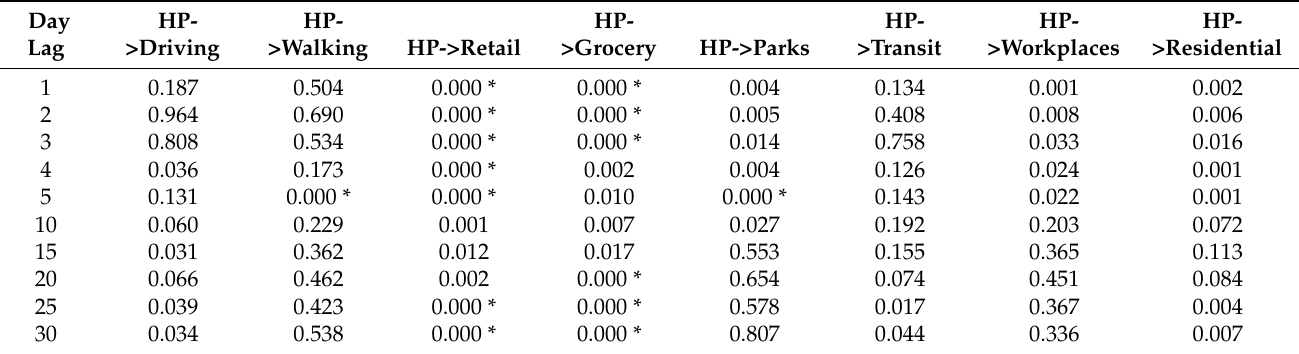
Table A20. Hosp_patients (HP), Granger-cause mobility variables, and p -values in day lags in